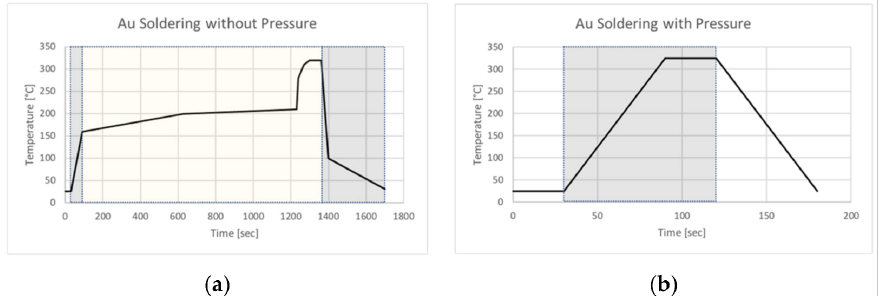
Figure 3. Temperature profile used for the soldering process with AuSn alloy as the interconnection material, without ( a ) and with ( b ) pressure. The grey regions indicate an N 2 atmosphere, while the light-yellow region indicates the additional presence of formic acid gas in the oven.